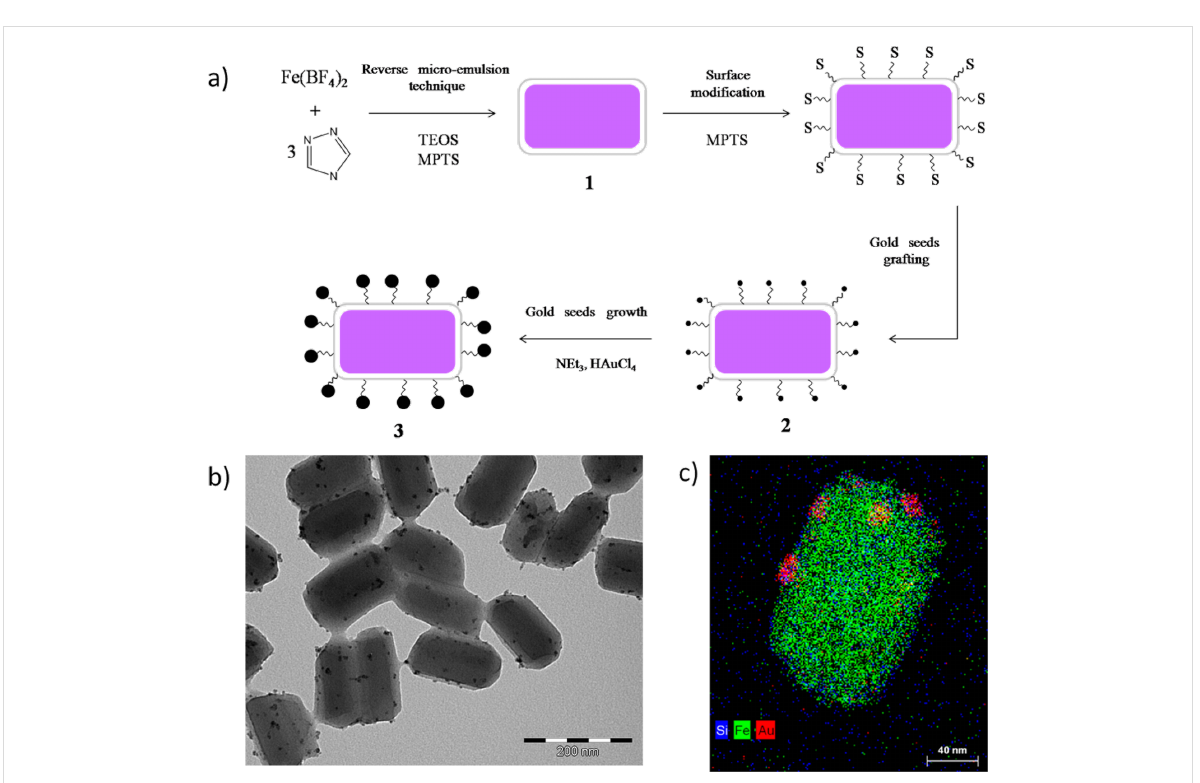
Figure 3: a) Schematic overview of the formation of the nanocomposite, gold-decorated SCO–SiO 2 nanoparticles. b) TEM and c) STEM–EDX images of the particles. Adapted with permission from [23], copyright 2014 The Royal Society of